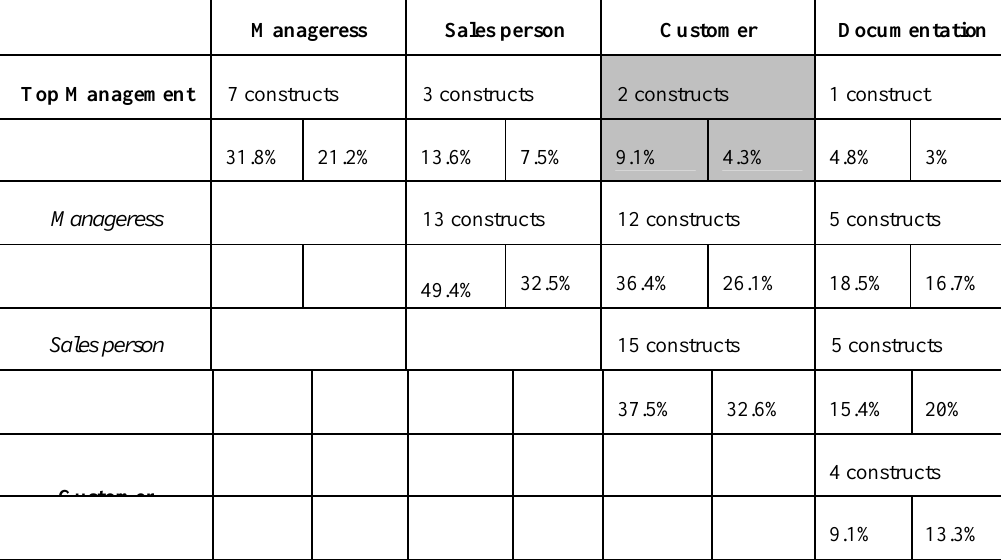
Table 2: Extent of overlap of significant constructs across the